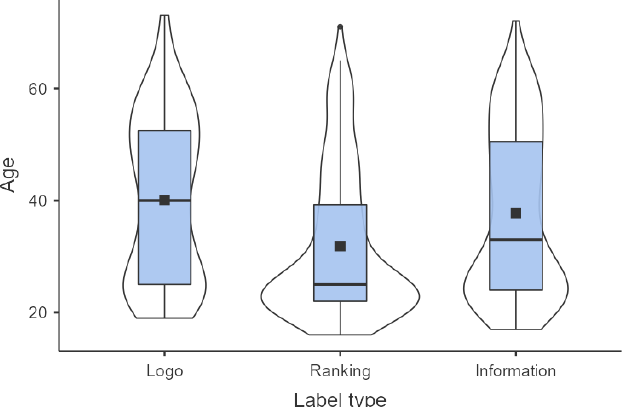
Figure 2. Box plot and violin plot of the age of the (potential) restaurant guests per menu label preference (logo, ranking, and information). The black square represents the average age per group (logo n = 107, ranking n = 164 and information n = 115). A box plot is a diagram with a box between the 25th and 75th percentile (IQR = interquartile range = P75–P25), a horizontal line at the median and a mean (square marker). The vertical lines (‘whiskers’) indicate the level of the highest or lowest observation within a distance of 1.5 IQR from the box. The violin plot is a smoothed density plot, where wide sections indicate a high density of observations [28].